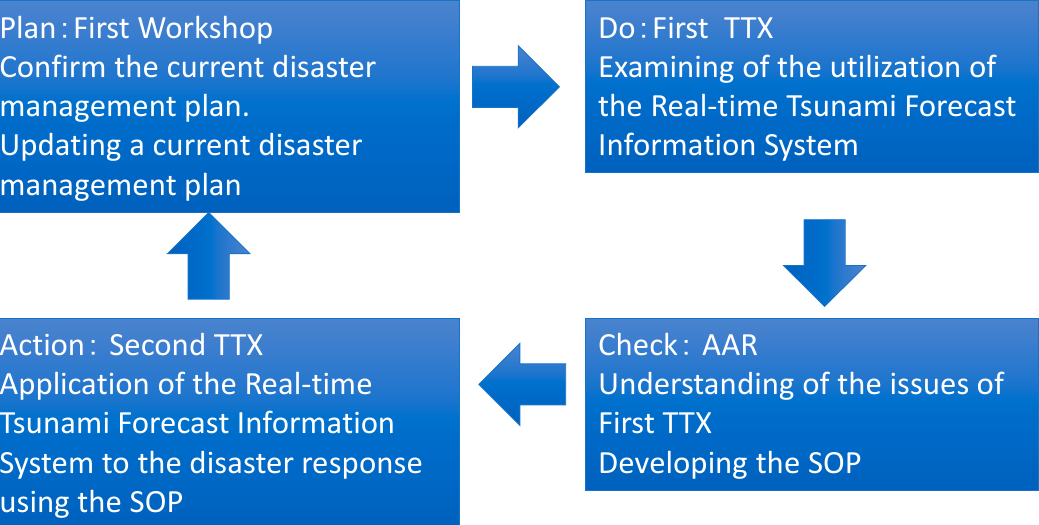
Figure 3. The Plan, Do, Check, Action (PDCA) cycle in this study. TTX: tabletop exercise; AAR: after-action review; SOP: standard operating procedure.